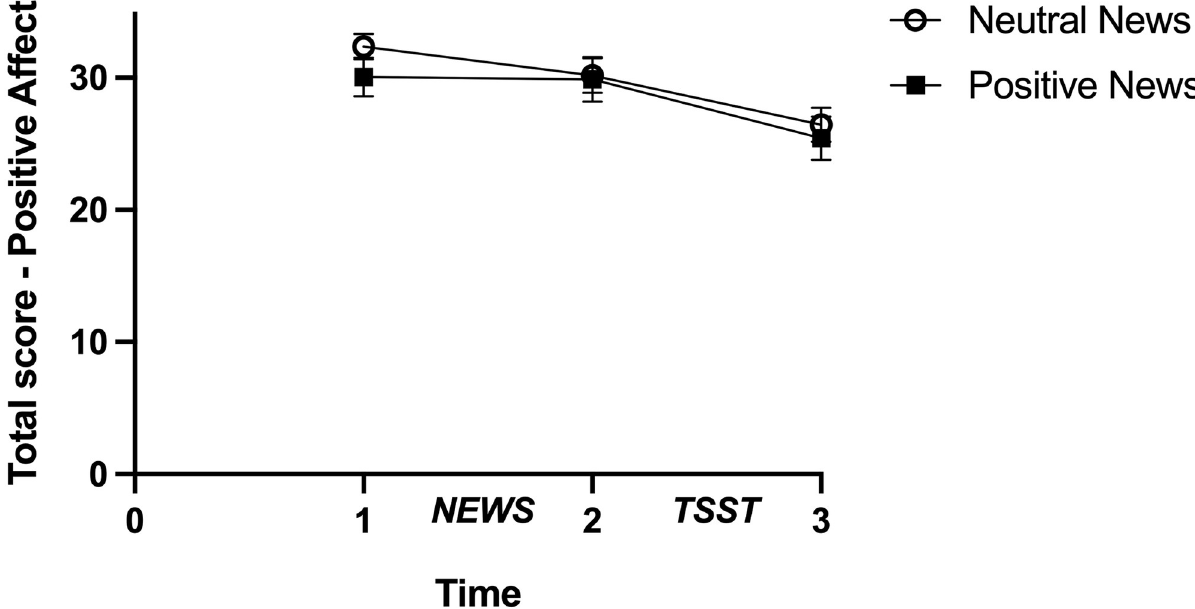
Fig 5. Score on positive affect, PANAS’s subscale in function of time as a function of condition. Non-adjusted means are presented and errors bars are the standard error of the mean.